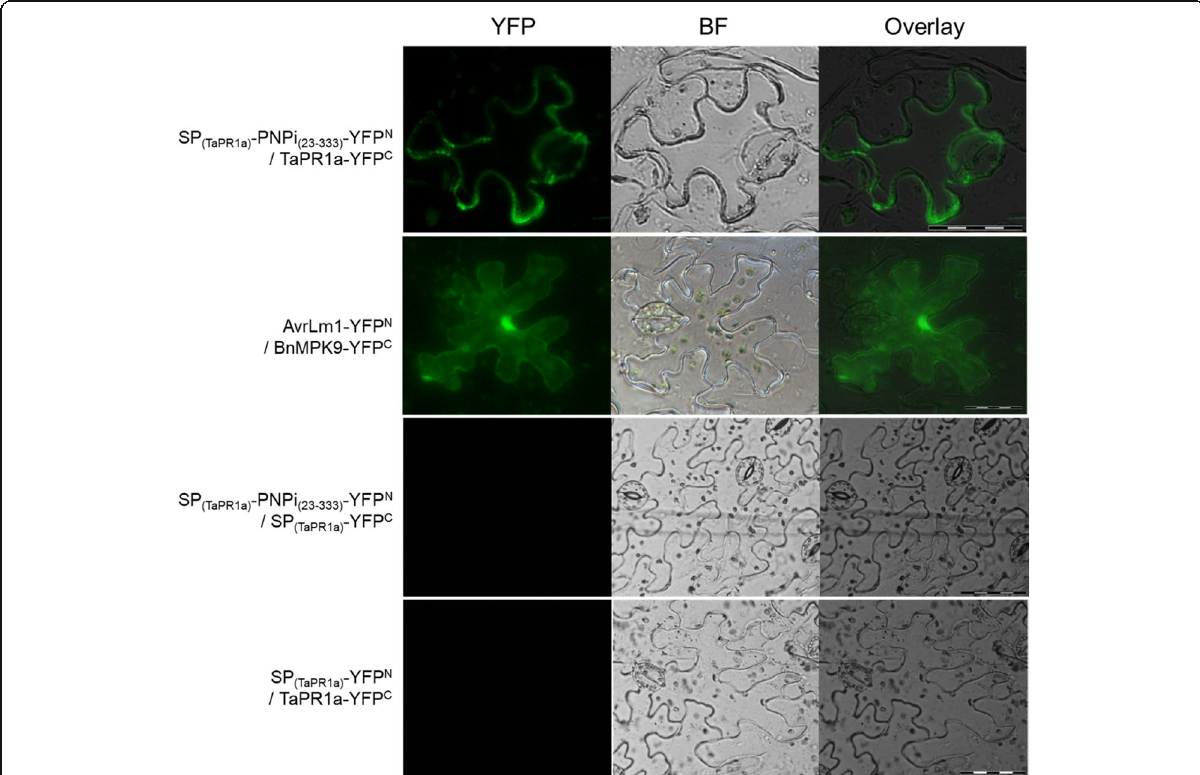
Fig. 3 The interaction of PNPi and TaPR1a proteins was detected by BiFC assay. YFP signals were detected in the leaves of N. benthamiana co- expressing SP (TaPR1a) -PNPi (23 – 333) -YFP N and TaPR1a-YFP C . Co-expression of AvrLm1-YFP N and BnMPK9-YFP C was utilized as a positive control. Co- expression of each recombinant vector with the corresponding TaPR1a signal peptide-fused YFP N and YFP C vectors served as negative controls. BF, bright field; EV, empty vector; YFP, yellow fluorescent protein. Scale bar = 100 μ